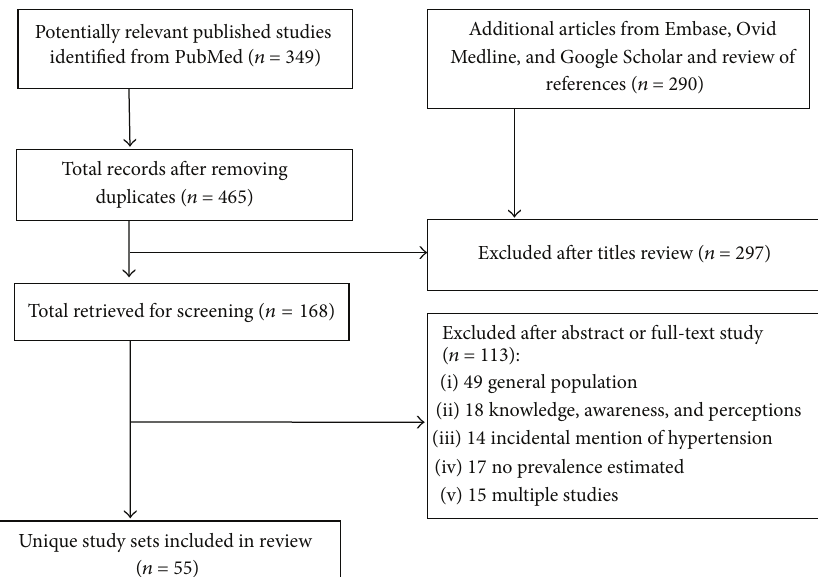
Figure 1: The process of selecting